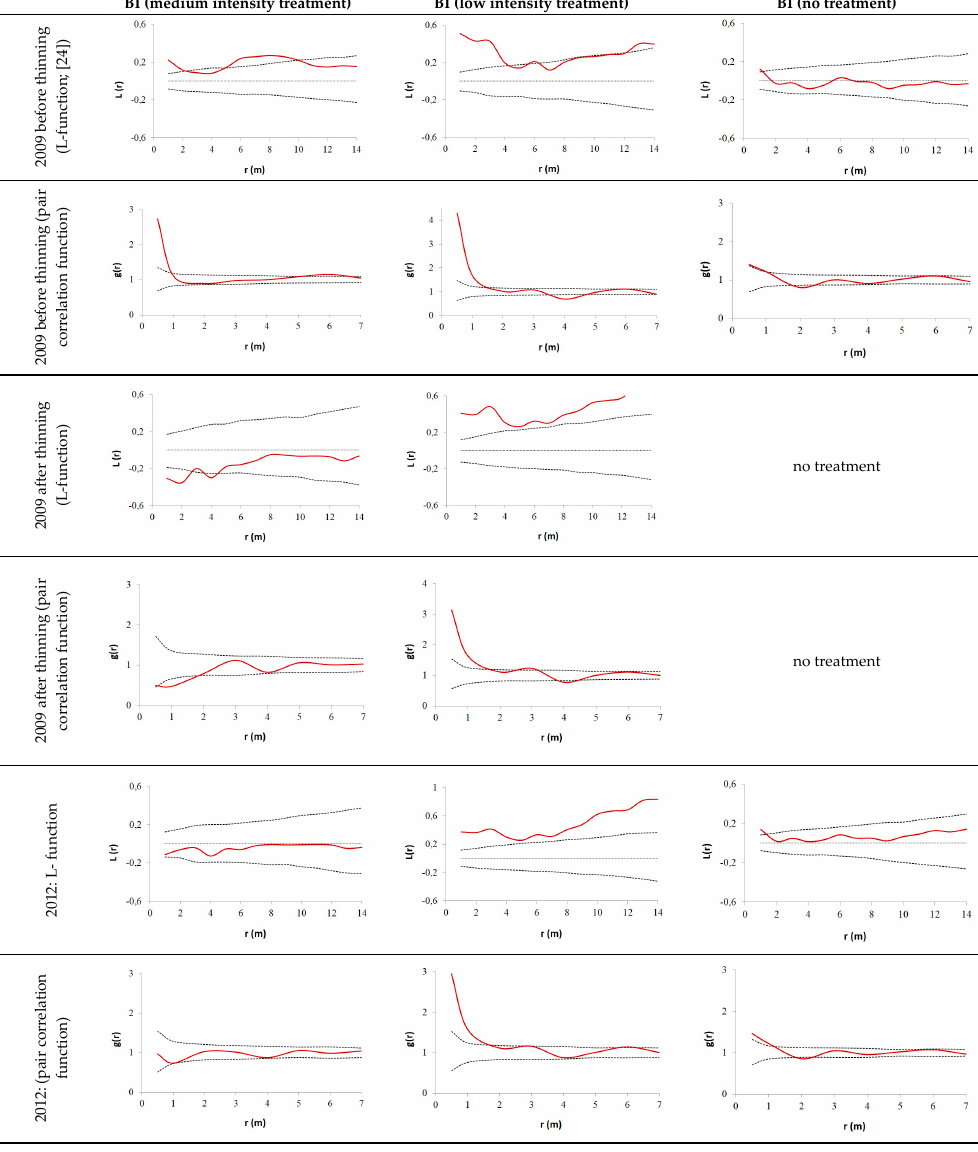
Figure 3. L-function and pair correlation function of the plots in stand BI before and after the thinning in 2009 and at the end of the observation period in 2012.